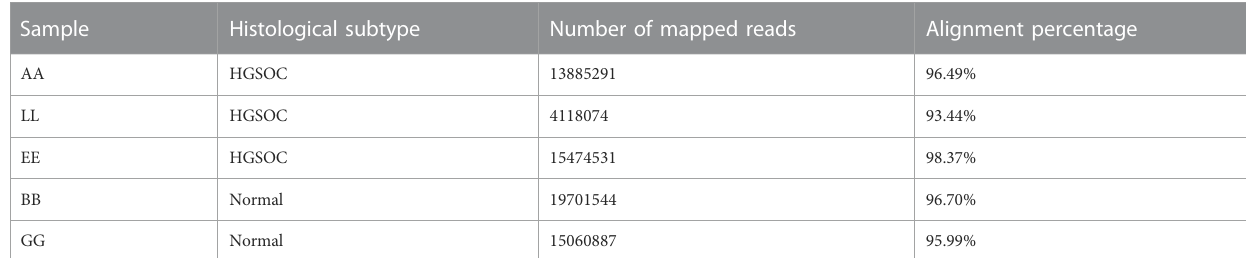
TABLE 6 miRNA sample